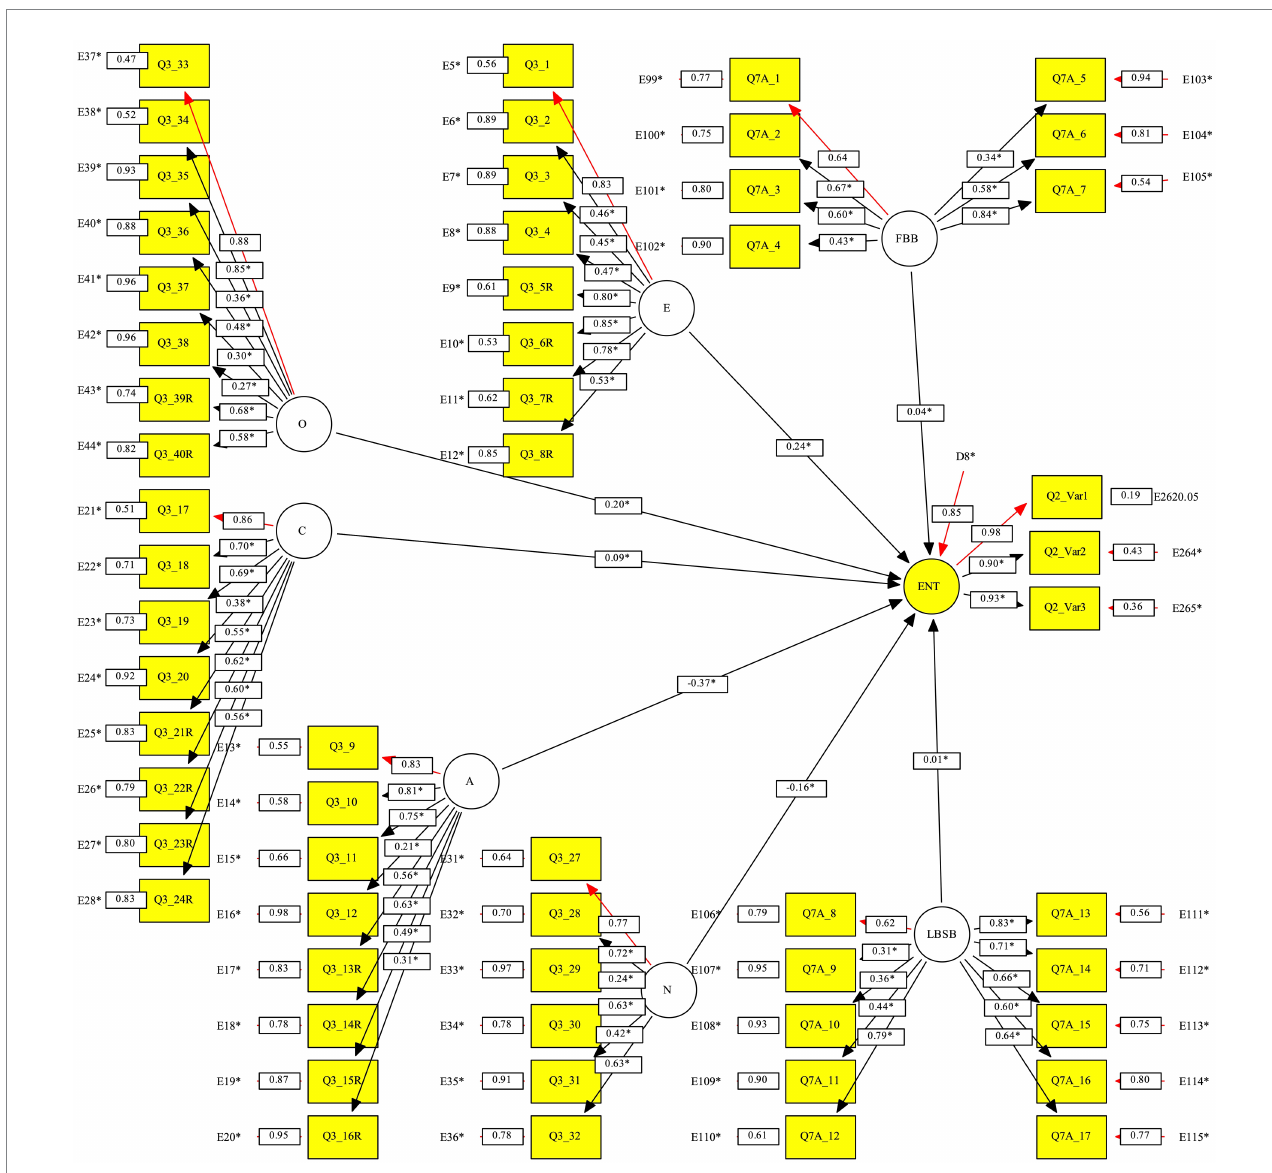
FIGURE 1 The model of the Big Five factors of personality, sociological entrepreneurial background, and establishment of companies (structural equation modeling, standardized solution). ENT, Entrepreneurship in terms of starting a business; O, Openness; C, Conscientiousness; E, Extraversion; A, Agreeableness; N, Neuroticism; FBB, Family business background; LBSB, Local business support background; Qx, items; Ex, errors; D, disturbance; *, estimated parameters.